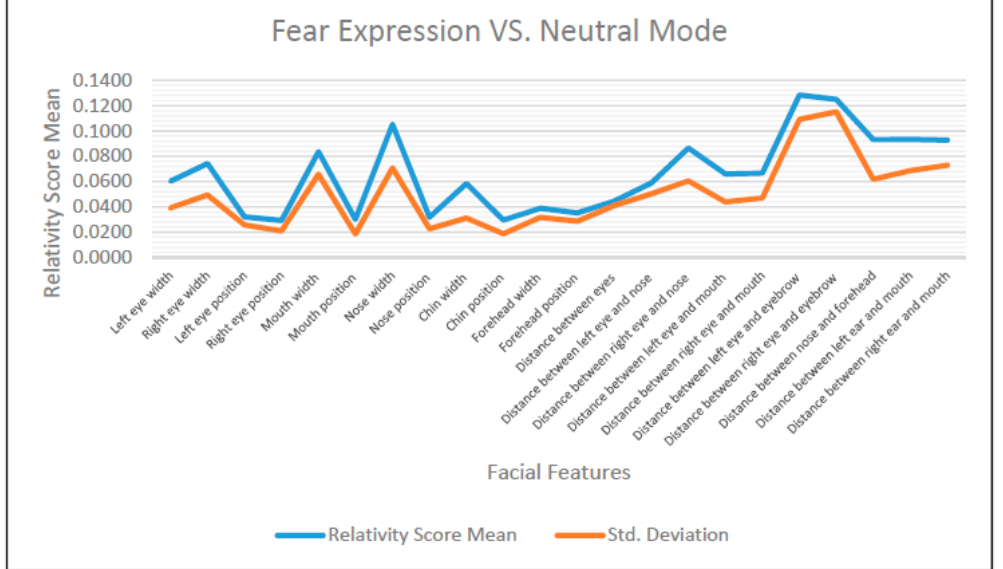
Figure 19. The means RSS between fear expression and neutral mode of 22 facial features for 36 subjects.